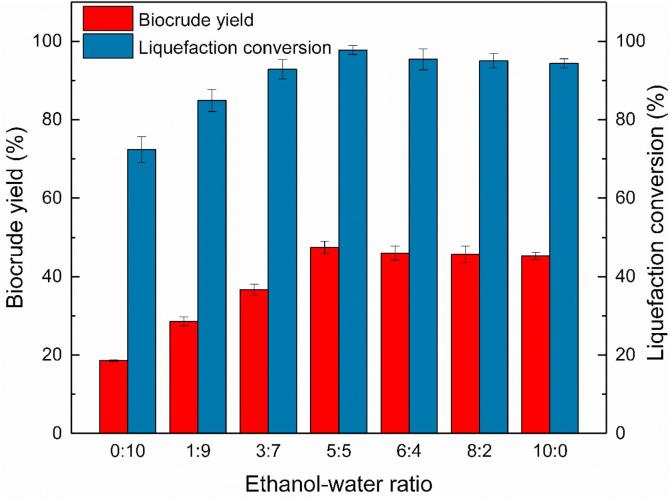
Effect of ethanol/water ratio on catalytic liquefaction of MSS with CuSO4.